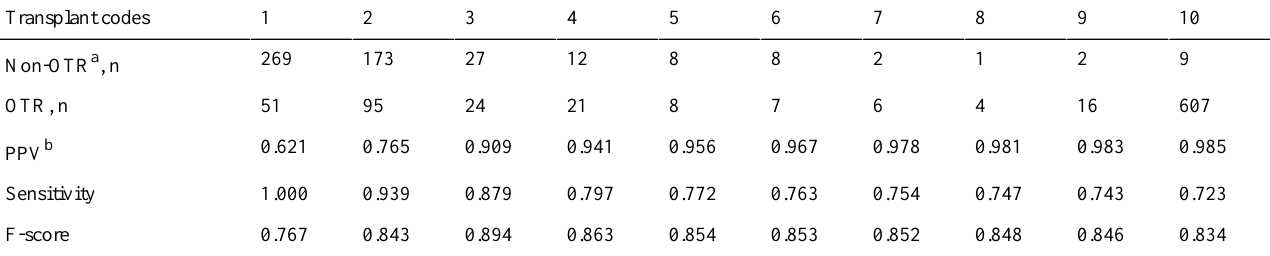
Table 2. Frequencies, positive predictive value, sensitivity, and F-score by code counts of organ transplant recipients and nonorgan transplant recipients.